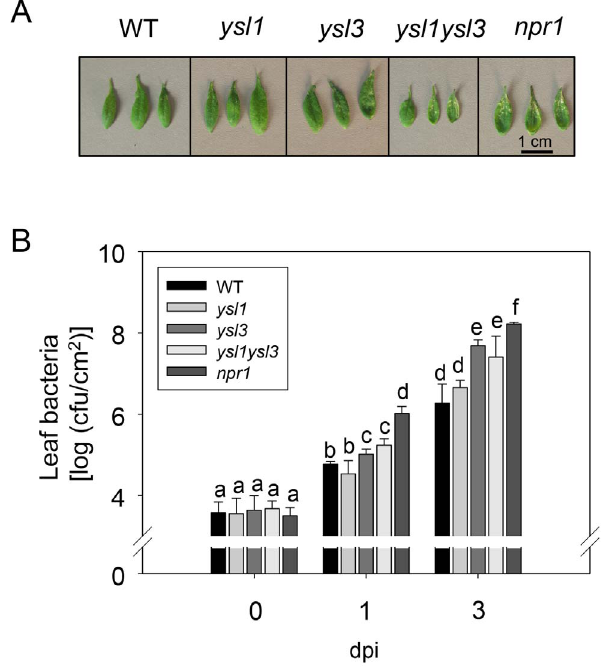
Figure 3. Mutation in YSL3 results in enhanced susceptibility to P. syringae pv. tomato ( Pst ) DC3000 infection. A, Disease symptoms on leaves of each Arabidopsis line after inoculation with Pst DC3000. Four-week-old Arabidopsis thaliana Col-0 wild type (WT), ysl1 , ysl3, ysl1ysl3 and npr1 grown in the soil were spray-inoculated with 10 7 colony-forming units (cfu)/mL Pst DC3000 in 10 mM MgCl 2 with 0.02% Silwet L-77 (hereafter Pst DC3000 solution). Photographs were taken 3 days post inoculation (dpi). B, Bacterial population in leaves of each Arabidopsis line 0, 1, and 3 days after inoculation. Data are mean 6 SD from 6 replicates. Different letters indicate significant difference at p , 0.05.